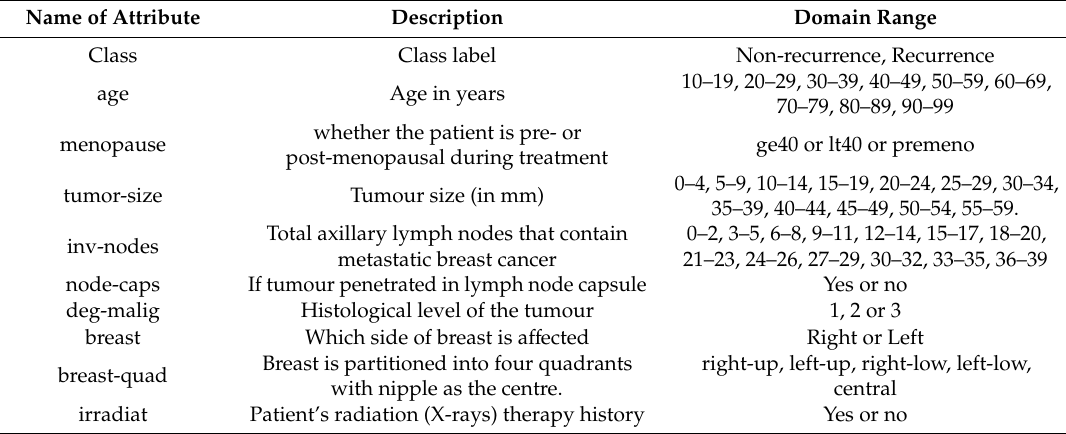
Table 4. Breast Cancer dataset details [79].